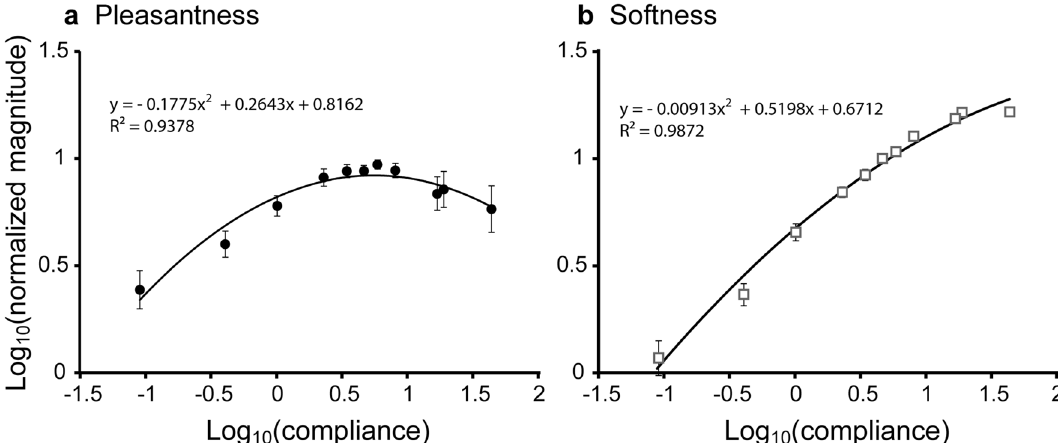
Figure 2. Magnitude estimates of pleasantness and softness. Mean log 10 normalized magnitude estimates of pleasantness and perceived softness plotted as a function of log 10 (compliance). Each data point indicates the mean ± standard error of the mean (SEM) of 24 participants. Note that the two groups of participants in each experiment evaluated softness and pleasantness